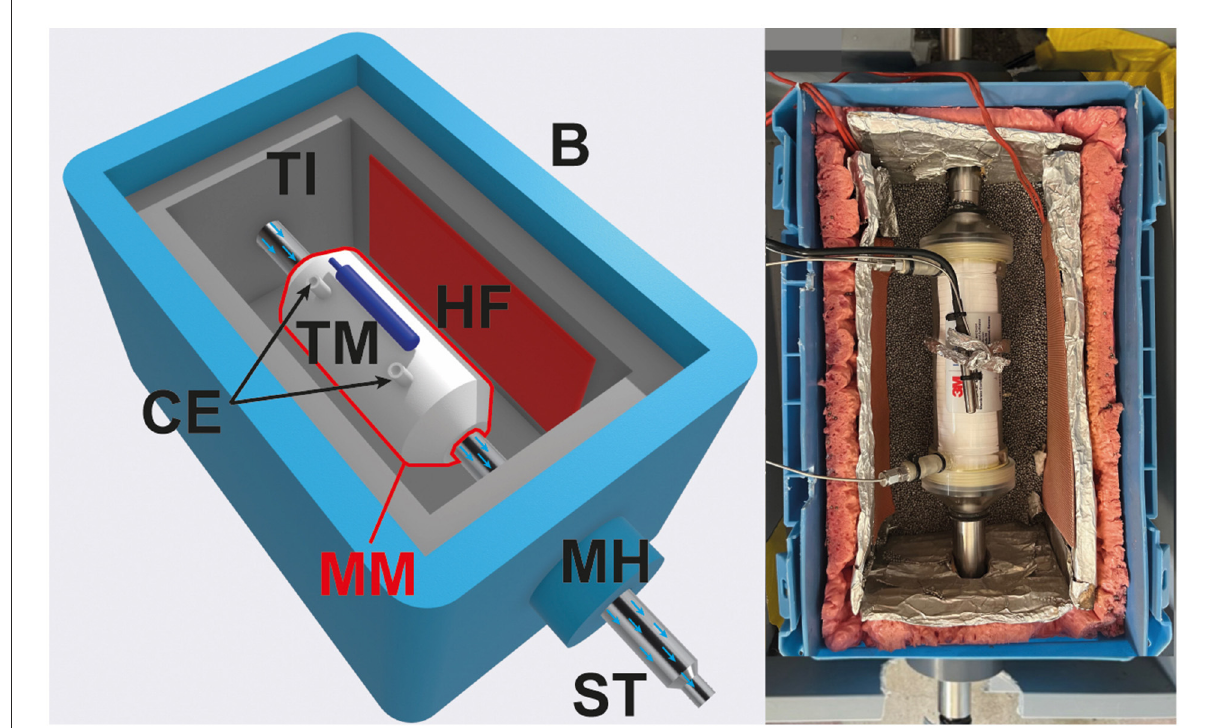
FIGURE1 Heating box for moderate temperature ranges of up to 65 ◦ C. The box (B) is thermally insulated (TI) and the void space is filled with metal castings. This provides a constant high temperature to the membrane module (MM). The heating foils (HF) heat the castings to a predefined temperature (i.e., above the temperature of the water/fluid being analyzed). The temperature is monitored by two thermometers (TM, represented by the blue part in the schematic view). The first belongs to the thermostat, while the second is monitored by the control unit to ensure that the temperature does not fall below the threshold. Two steel tubes (ST) are connected to the membrane module and circulate the thermal water. Water is entering on one side, passes through the gas permeable membrane inside the module, and exits on the other side. Mechanical stresses on the membrane module were reduced by mechanical holds (MH) which distributed forces to the box rather than to the membrane module. Two capillary entries (CE) allow to measure the partial pressure of individual gas species in the headspace of the MM, whose gas phase is in equilibrium with the dissolved gases in the liquid phase under